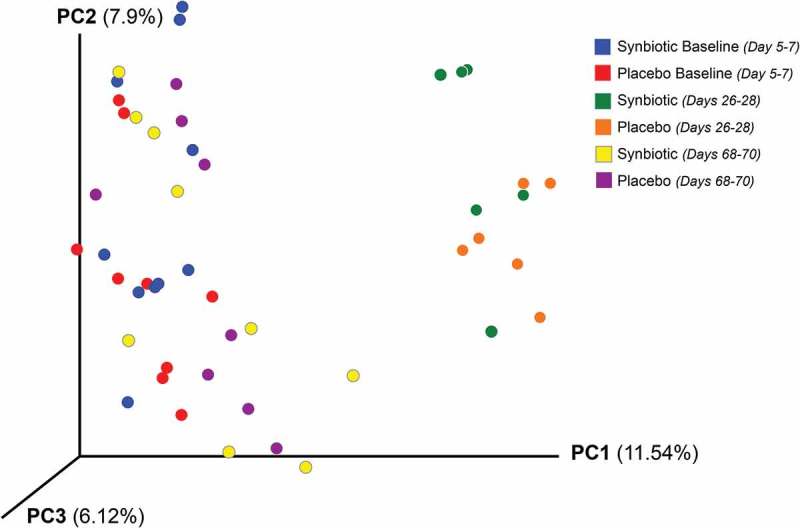
Principal coordinate analysis (PCoA) of unweighted uniFrac distances of 16S rRNA genes.Gene sequences were determined using fecal samples collected at baseline (days 5–7), at the conclusion of antibiotic administration (days 26–28), and after a 6-week washout (days 68–70) from 16 healthy cats, 8 per group,+ that received 75 mg clindamycin followed 1 h later by either two capsules of a placebo or synbiotic PO once daily for 21 days. +Feces not available from four cats at time point 26–28 because of early termination of treatment due to severe gastrointestinal signs.